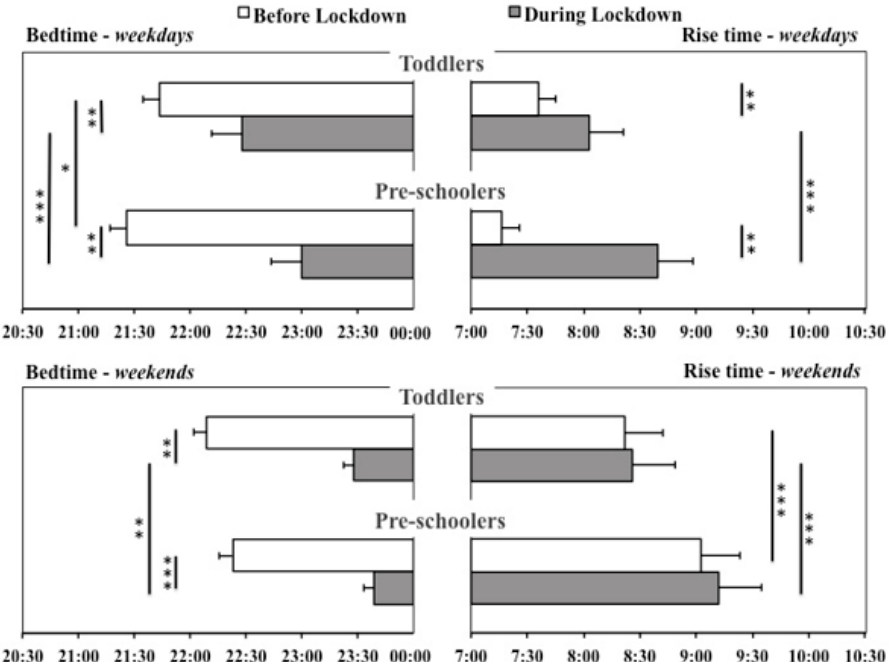
Figure 1. Bed- and rise times on weekdays and weekends in toddlers and pre-schoolers before and during the lockdown. Error bars represent standard error of the mean. Significant within-groups and between-groups comparisons are reported. * p < 0.025; ** p < 0.01; *** p < 0.001. On weekdays, bed- and rise times were significantly delayed during the lockdown (compared to the pre-pandemic period) in both age groups (all four p ’s < 0.003). This lock- down-related delay was more pronounced in pre-schoolers, as indexed by the fact that, relative to toddlers, their bedtimes were earlier before the lockdown ( p = 0.020) and both their bed- and rise times were later during the lockdown (both p ’s < 0.001). As for weekends, bedtimes were delayed in both toddlers ( p = 0.008) and pre-school- ers ( p < 0.001) during the lockdown relative to before, whereas rise times were unchanged in both groups. Between-groups comparisons revealed that, before the lockdown, bed- times did not differ between groups, whereas pre-schoolers went to bed significantly later during the lockdown ( p = 0.008). Pre-schoolers also displayed later weekend rise times both before and during the lockdown (both p ’s < 0.001). Napping frequency increased during the lockdown in both toddlers ( p = 0.004) and pre-schoolers ( p = 0.01). Between-groups comparisons revealed that pre-schoolers napped more frequently than toddlers both before and during the lockdown (both p ’s < 0.001). 3.4. Differences in Children’s Sleep Quality across Time Points and Age Groups Figure 2 displays CSHQ total scores before and during the lockdown in toddlers and pre-schoolers. Scores at the CSHQ subscales are shown in Table 3.